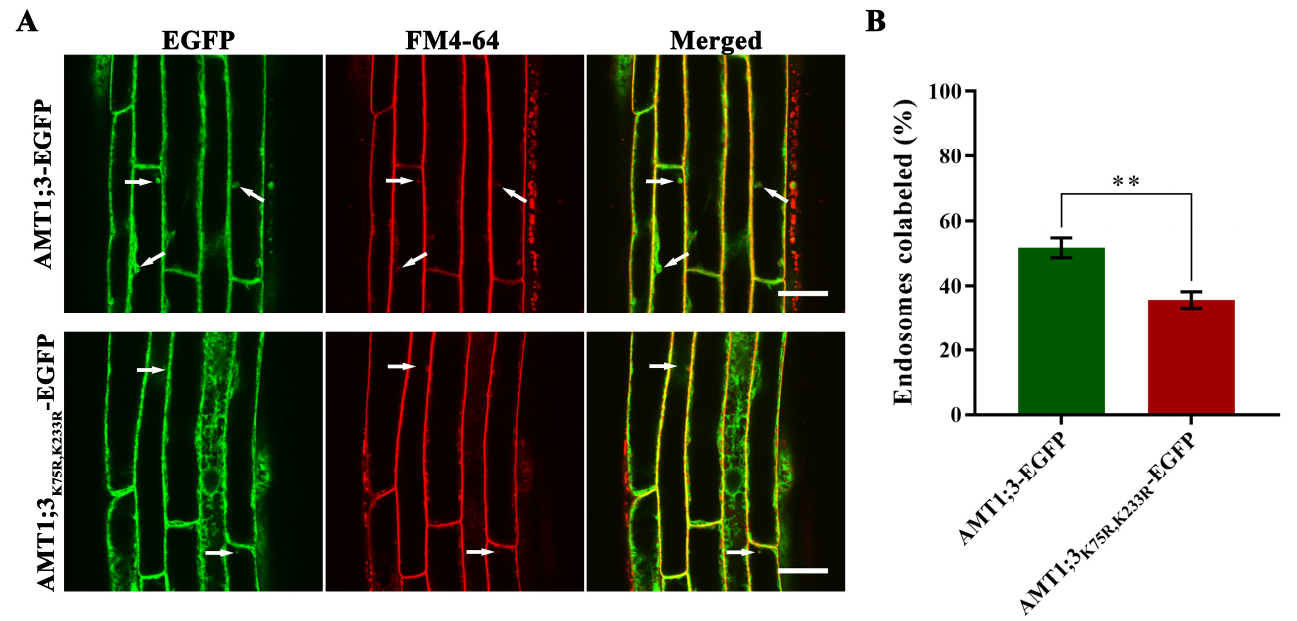
Figure 3. The ubiquitinated forms of AMT1;3 proteins affect its endocytosis. ( A ) The partial colocal- ization of AMT1;3/AMT1;3 K75R,K233R -EGFP with FM4-64. The left photographs represent GFP signal showing subcellular localization of AMT1;3/AMT1;3 K75R,K233R -EGFP. The middle photographs repre- sent red fluorescence signal showing the plasma membrane stained by FM4-64. The right photographs represent the merge of AMT1;3/AMT1;3 K75R,K233R -EGFP and FM4-64 staining. Scale bars = 20 μm. White arrows indicate the colocalization spots of AMT1;3/AMT1;3 K75R,K233R -EGFP and FM4-64. ( B ) Statistics of the colocalization of AMT1;3/AMT1;3 K75R,K233R -EGFP with FM4-64. ** p < 0.01, t test. Error bars represent the mean ± SD.